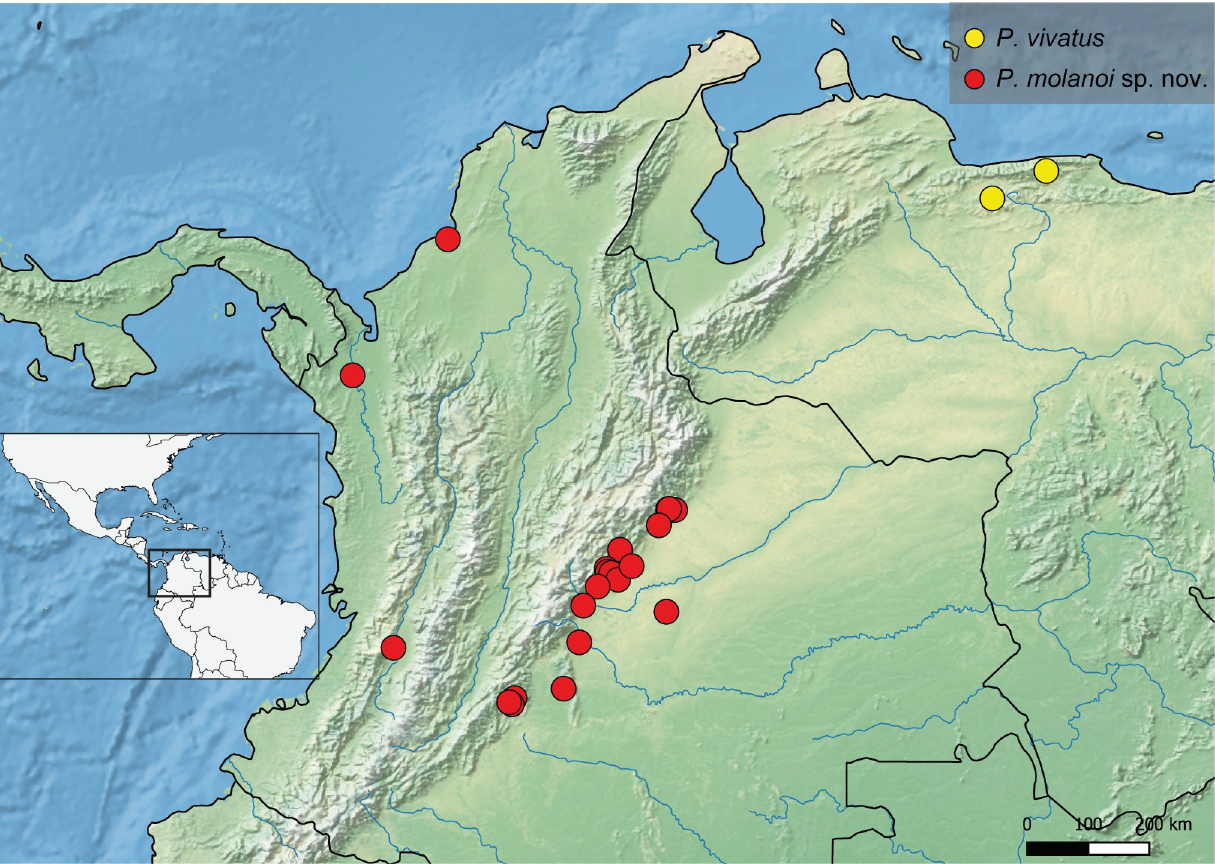
Fig 39. Map showing the geographical distribution of species of P . vivatus , P . molanoi sp. nov. Spatial data from Natural Earth (http://www.